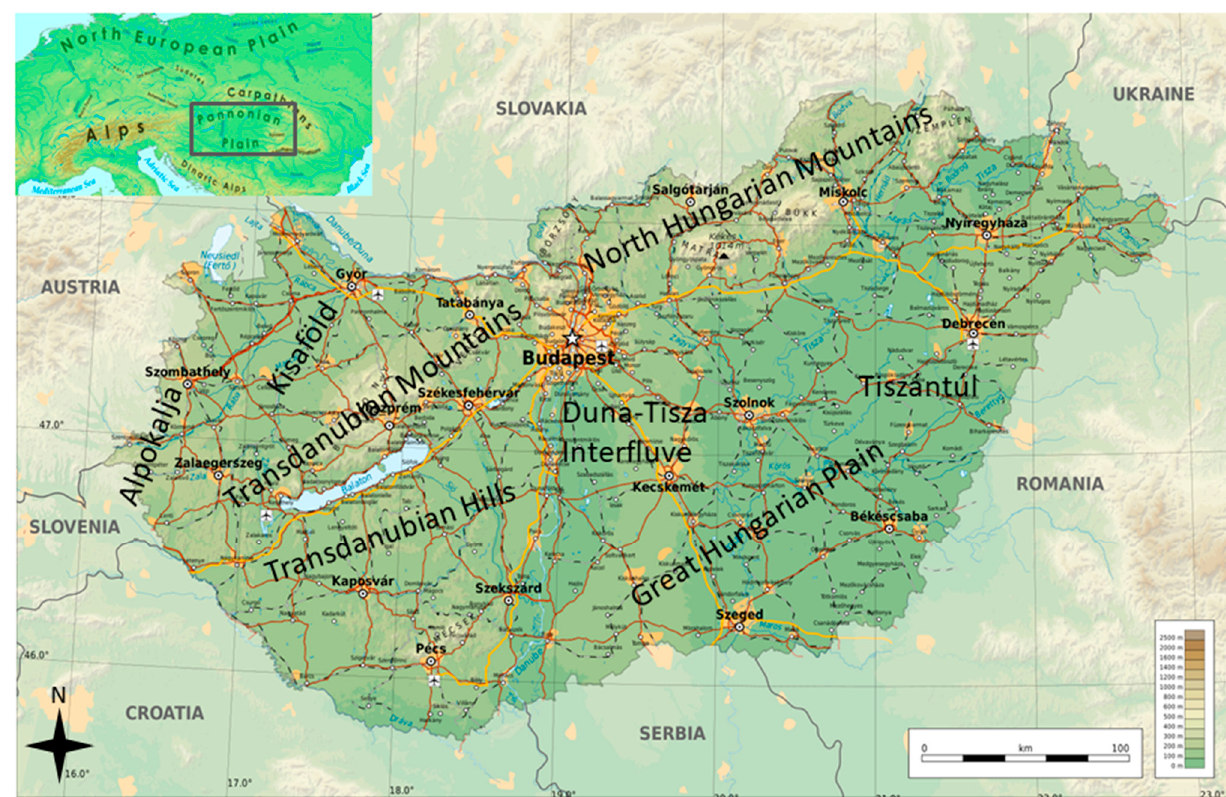
Figure 1. Main geographic regions of Hungary.